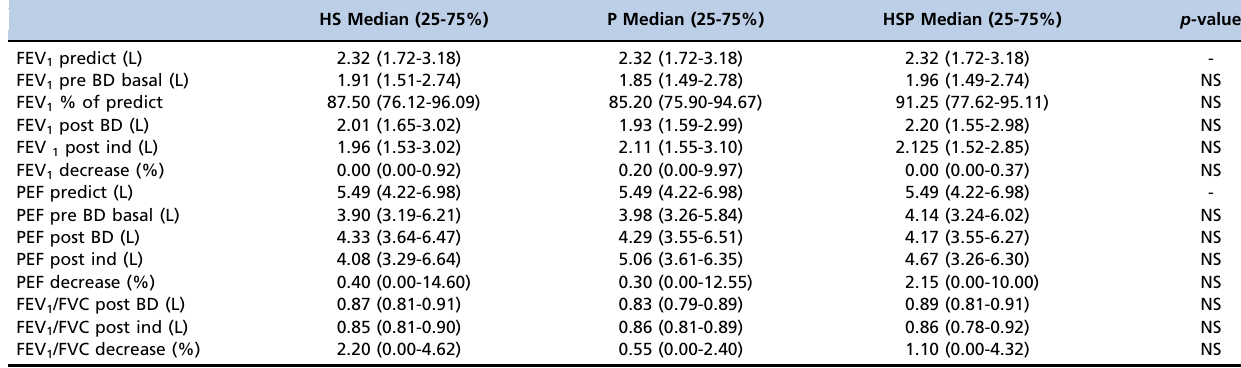
Table 1 - Pulmonary function.